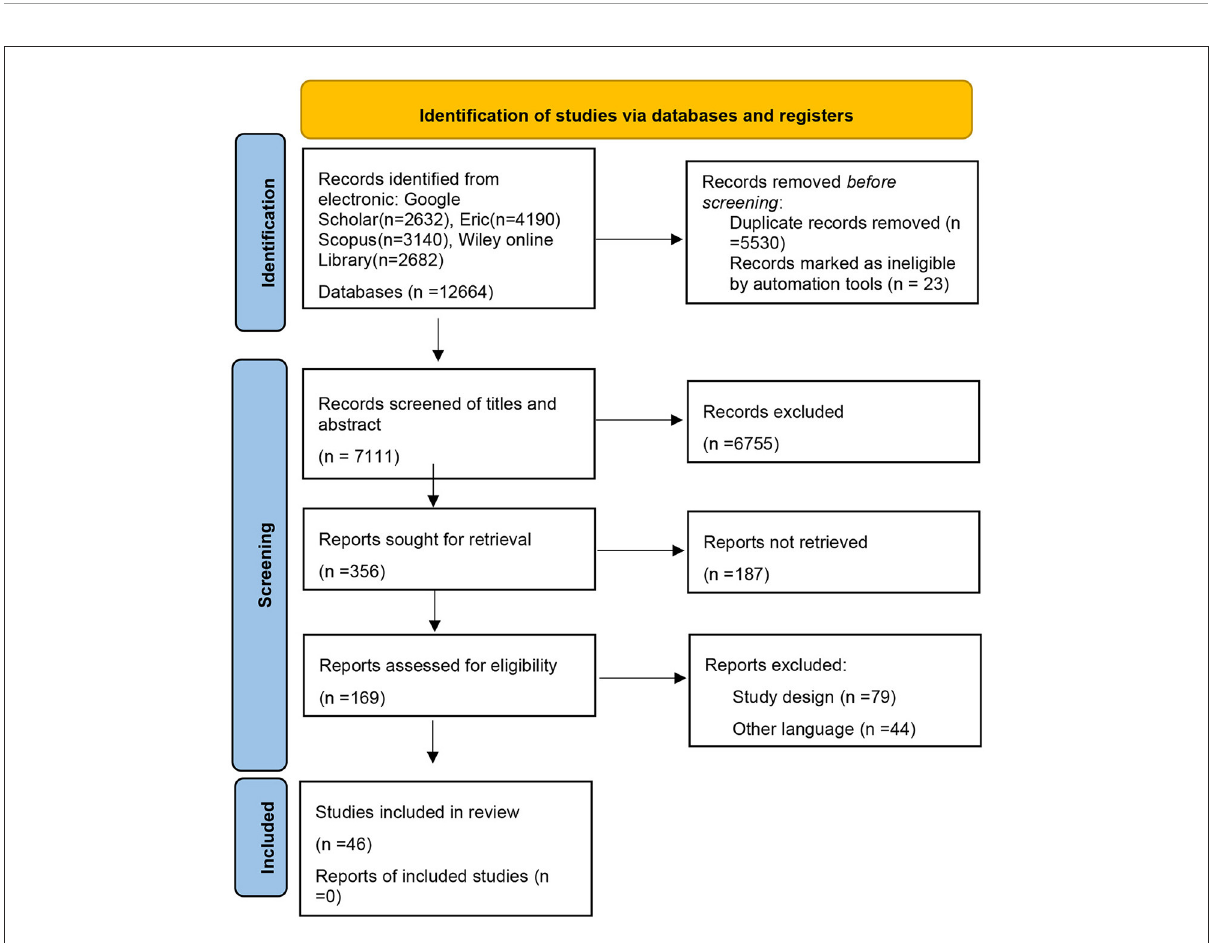
FIGURE3 PRISMA 2020 flow diagram for systematic literature